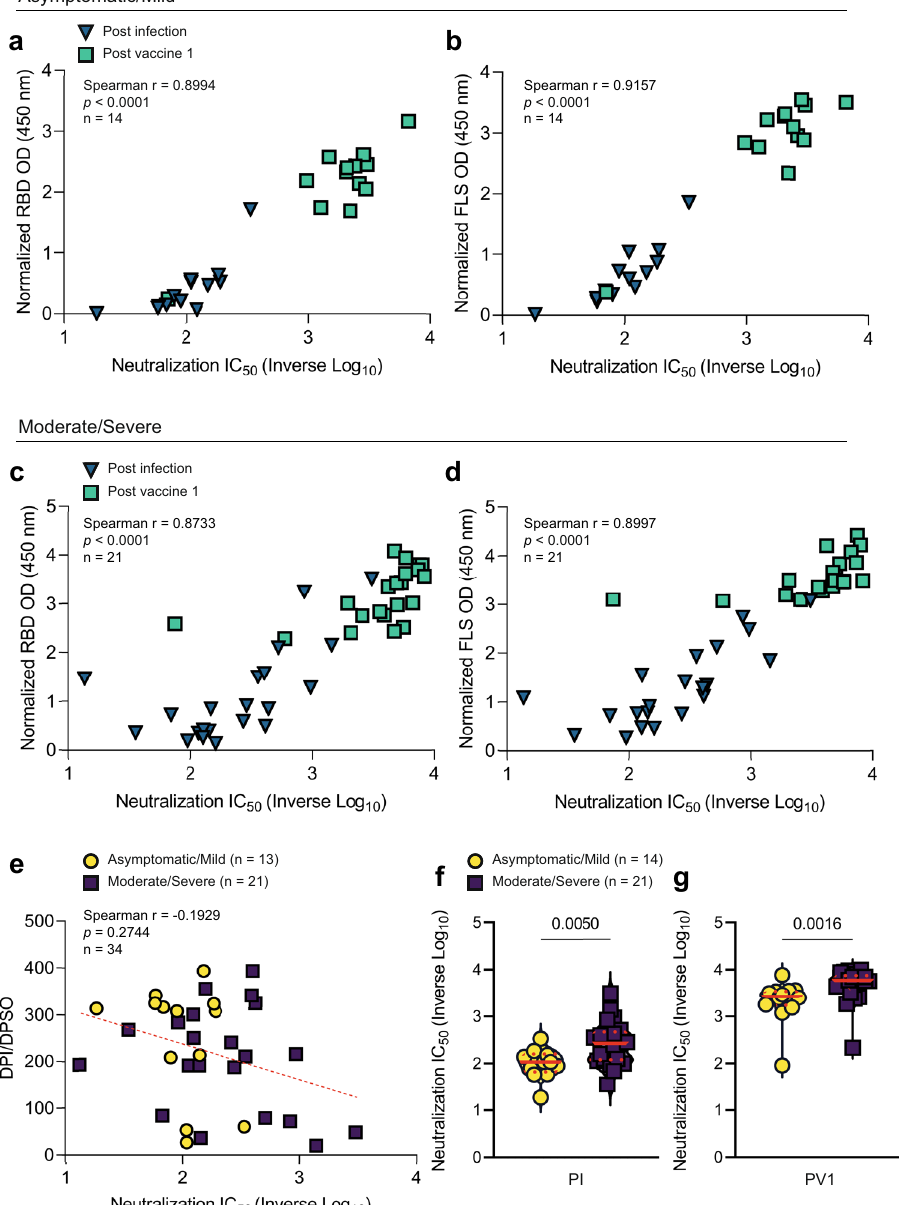
Fig. 3 Neutralizing antibody titres and comparisons between groups. Correlations between half-maximal log 10 inhibitory concentrations (IC 50 ) of antibodies required to neutralize rVSV-S infection of Vero cells vs normalized a anti-RBD IgG or b anti-FLS IgG OD levels after infection (blue chevron) and PV1 (teal square) in the asymptomatic/mild and c , d moderate/severe groups are depicted. The relationship between days post infection or days post symptom onset at collection (DPI/DPSO) is illustrated in ( e ). Neutralization capacity of Ab activity acquired f post infection and g PV1 was compared between the asymptomatic/mild (yellow circle) and moderate/severe (purple square) groups. P values in f , g were calculated using the Mann – Whitney U -test. Red lines bisecting groups represent median (solid) with IQR experiencing moderate/severe COVID-19, both post infection Neutralization capacity of plasma Ab correlated strongly with anti- (Fig. 3f, log 10 2.00 versus log 10 2.44, p = 0.005) and after primary RBD and anti-FLS IgG levels measured by ELISA and increased following vaccination in both groups (Fig. 3a – d). Despite the vaccination (Fig. 3g, log 10 3.33 versus log 10 3.67, p = 0.002). The strong correlation overall, one person had low neutralization higher levels of anti-RBD and anti-FLS antibodies induced in capacity relative to their absolute IgG Ab levels against RBD and persons experiencing moderate/severe COVID-19 corresponded FLS (Fig. 3c, d), illustrating the potential for qualitative differences with greater neutralization capacity both following recovery from in the neutralizing activity of Ab against RBD and FLS. There was infection and after primary vaccination. considerable variability within both groups, which was not simply Anti-S Ab can physically prevent virus-cell interactions required due to Ab waning as time since infection did not correlate for infection and can also enact Fc receptor-dependent antiviral signi fi cantly with neutralization capacity (Fig. 3e). Median log 10 functions. To assess the extent to which anti-S Ab produced during infection mediated Ab-dependent cell-mediated cytotoxicity inhibitory titers were signi fi cantly higher for the group